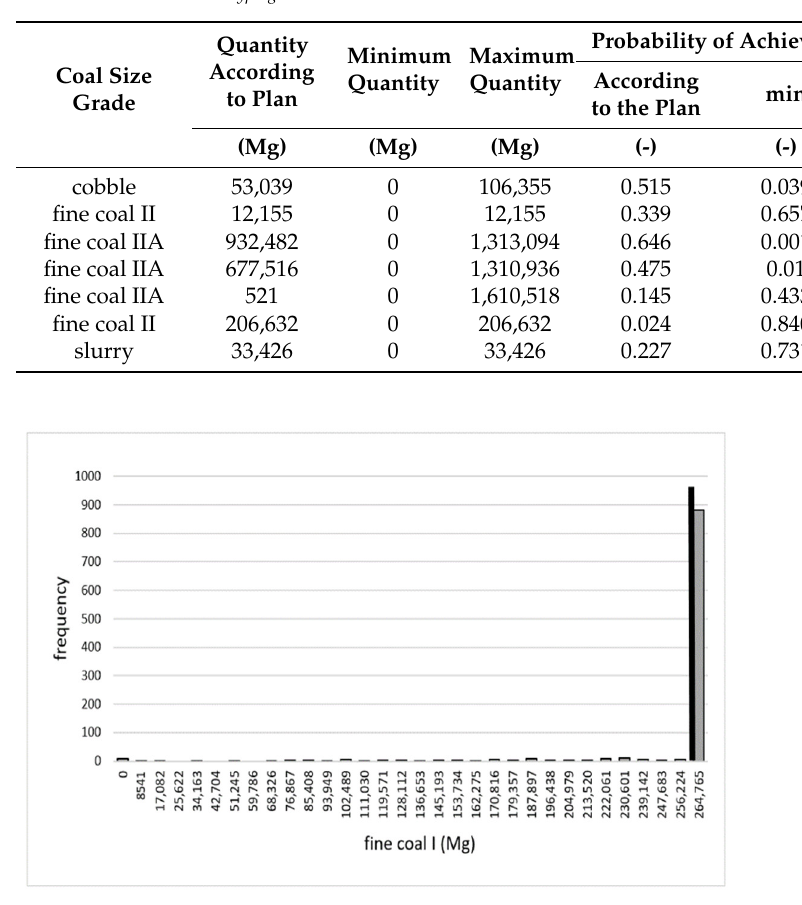
Table A15. A summary of the volumes of sales of the individual coal grades with the probability of their achievement at σ yprog for mine “G”.